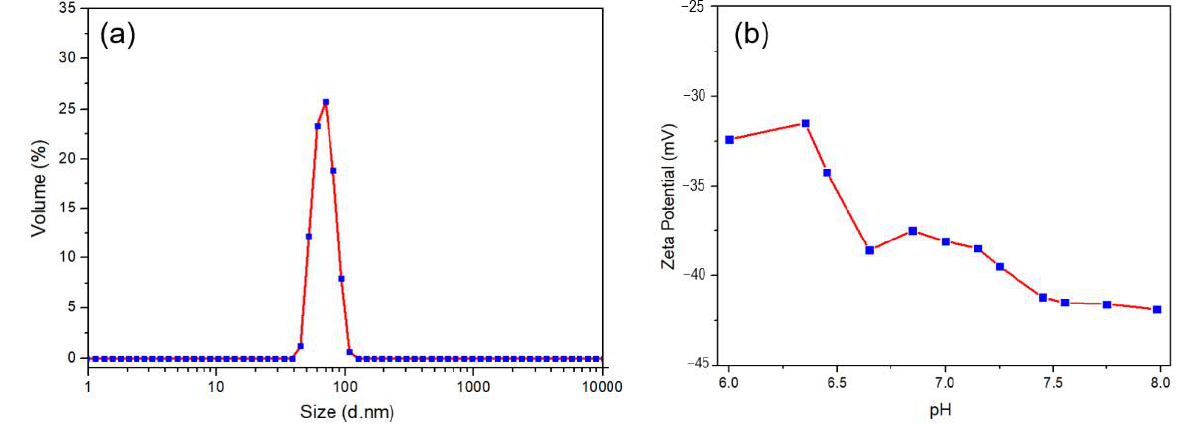
Figure 4. DLS measurements of NBC dispersion in deionized water: ( a ) volume-weighted size distribution; ( b ) zeta potential measurements at the pH range of 6–8.